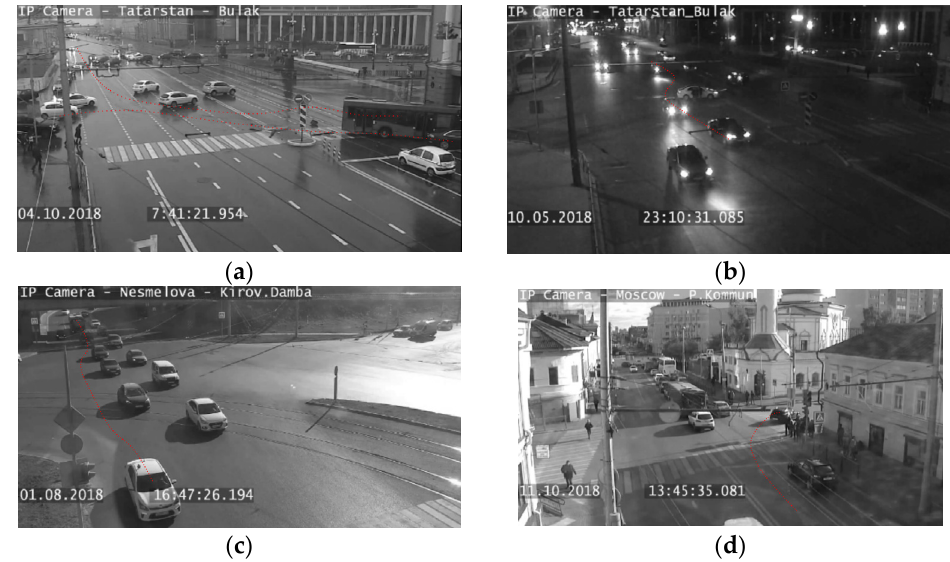
Figure 3. Types of spatial trajectory anomalies. ( a ) Traffic accident; ( b ) Unexpected obstacle; ( c ) Inadequate driving; ( d ) Violation of traffic rules.